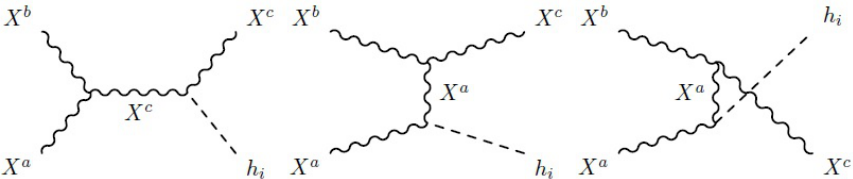
Figure 15 . Feynman diagrams for DM semi-annihilation, with h i = { H, S }